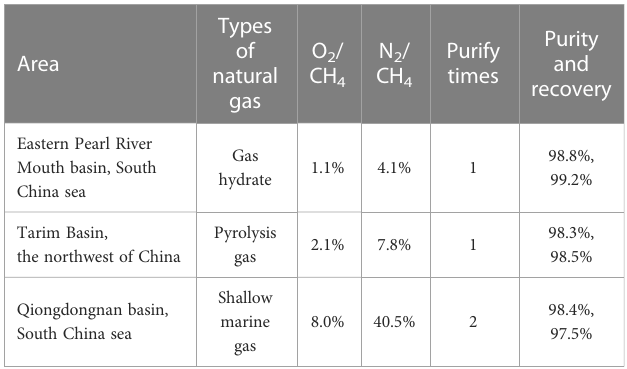
TABLE 6 Puri fi cation results of different types of natural gas.